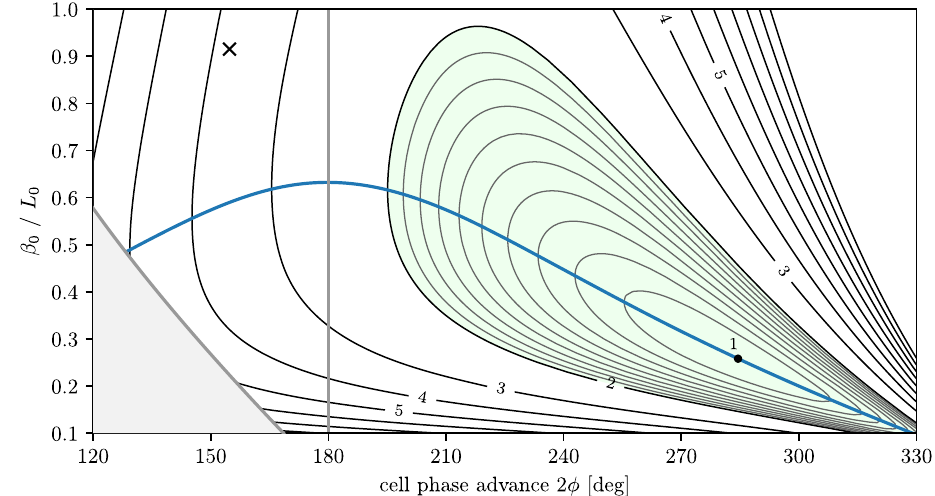
FIG. 3. Emittance ratio F in the ð β 0 ; ϕ Þ plane for HOM cells. Black isolines show values of F in integer steps up to 10. The gray isolines in the green area show values F < 2 in steps of 0.1. The blue line shows β opt 0 ð ϕ Þ , resulting in minimal emittance at a given phase. The TME condition F ¼ 1 is indicated by a black dot. The example cell parameters are indicated by the cross marker. Parameters in the gray area (bottom left) are not attainable.